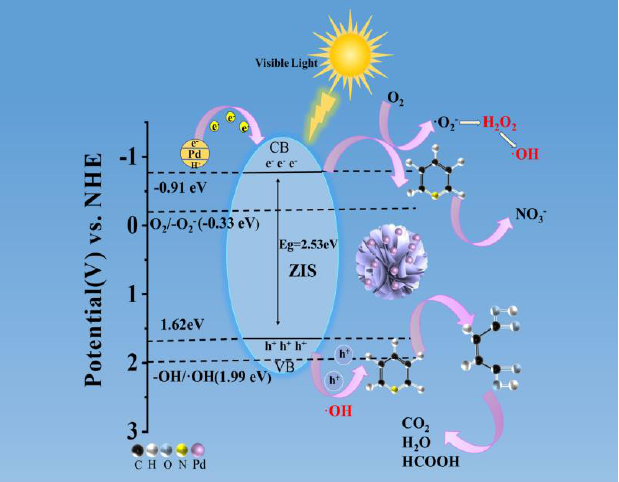
Figure 11. Possible photocatalytic denitrification mechanism of Pd-modified ZIS.